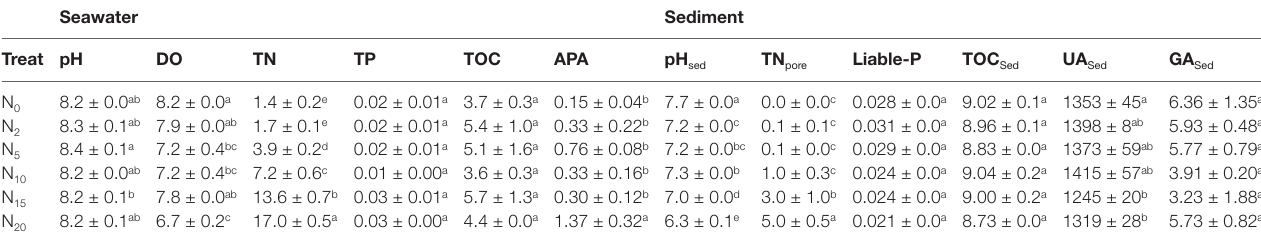
Different letters in same columns of each denote a significant difference at p < 0.05 between treatments (one-way ANOVA statistics). The highest value in each column is labeled “a”. DO, dissolved oxygen (mg L −1 ). TN, total nitrogen (mg L −1 ); TP, total phosphorus (mg L −1 ); TOC, total organic carbon (mg L −1 ); APA, bacteria alkaline phosphatase activity (μg P